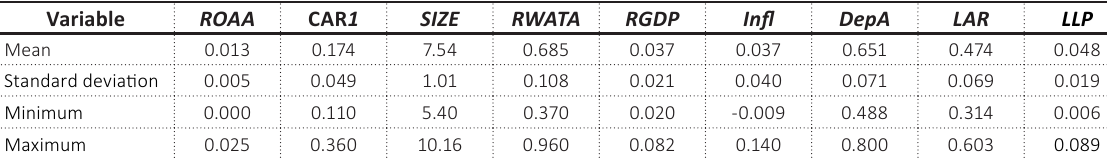
Table 2. Descriptive statistics